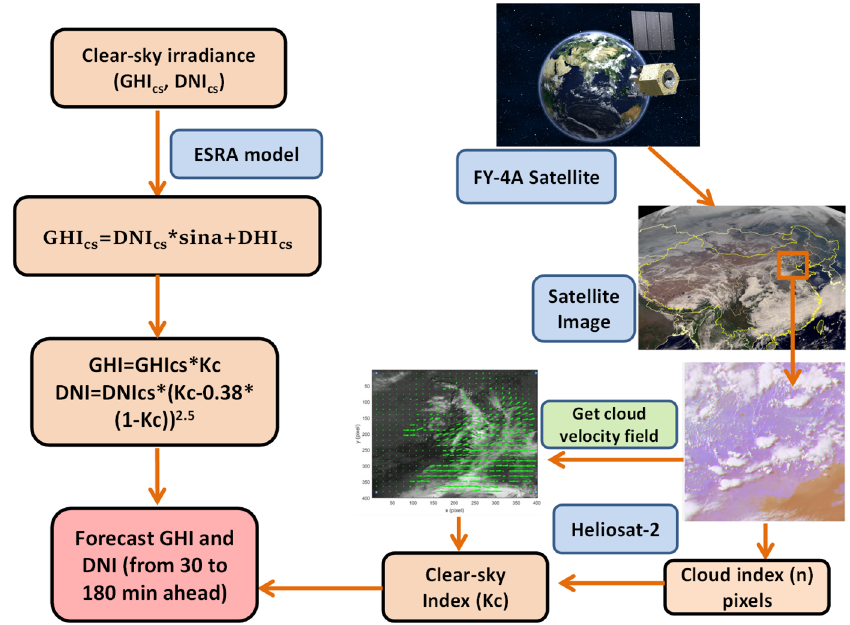
Figure 4. Overview of GHI and DNI forecast process with time horizons of 30 to 180